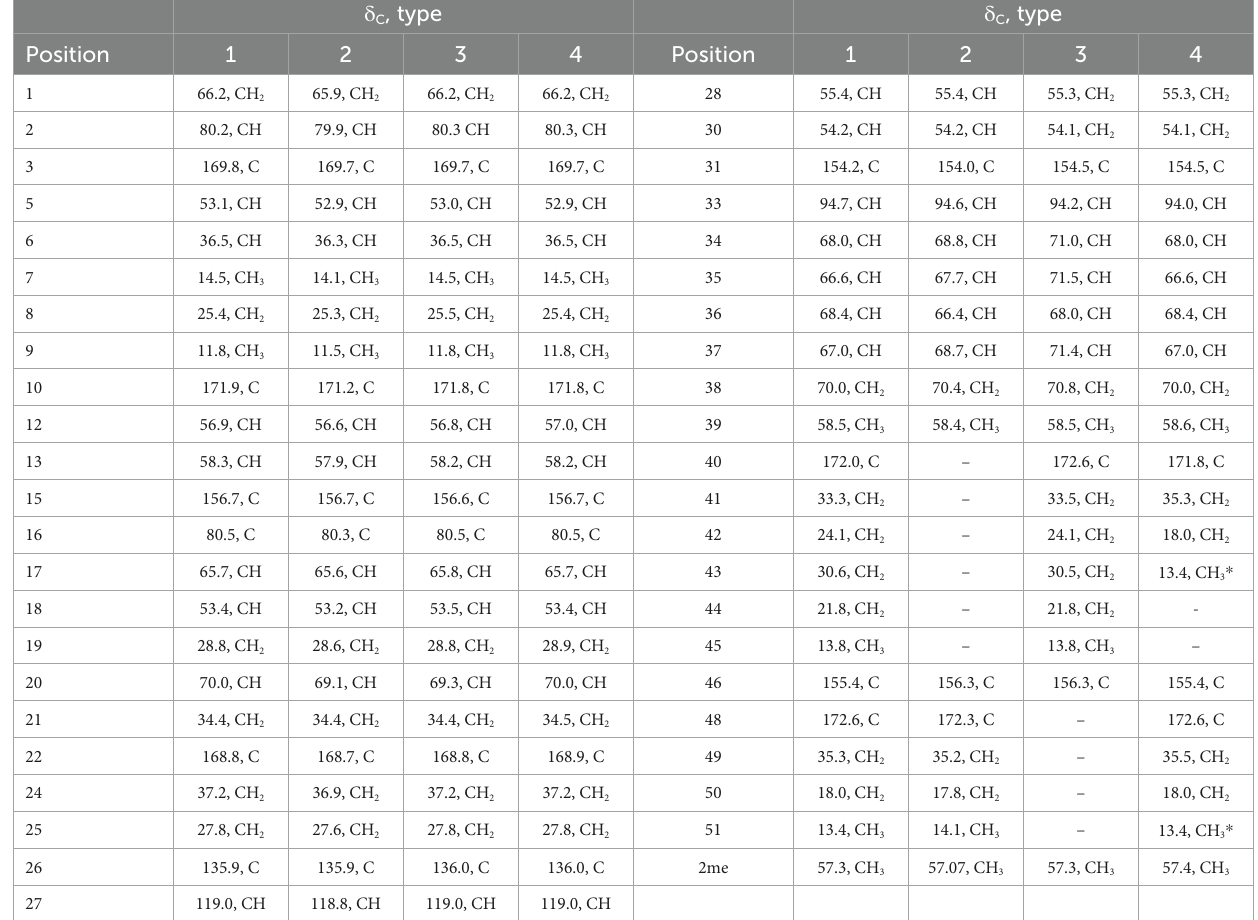
TABLE 2 13 C NMR assignments for suomilides B – E ( 1 – 4 ) ( 13 C 150 MHz, DMSO-d 6 ). δ C , type δ C ,